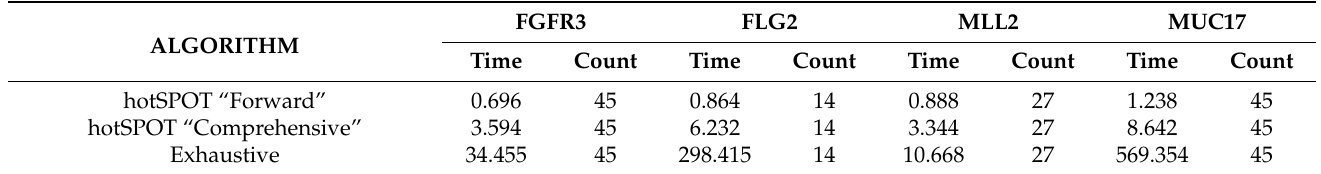
Table 2. The comparison of computation time (seconds) and mutation count for four genes in dataset A, based on hotSPOT algorithms and comprehensive